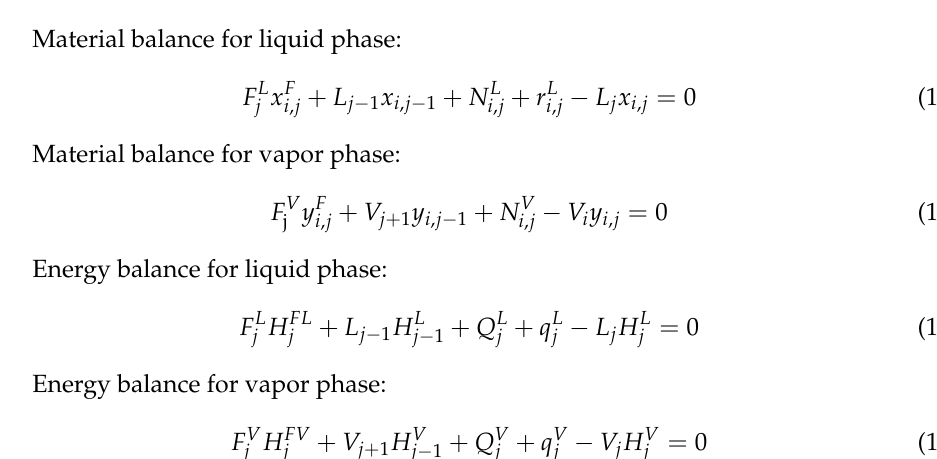
Figure 1. Rate-based stage model.